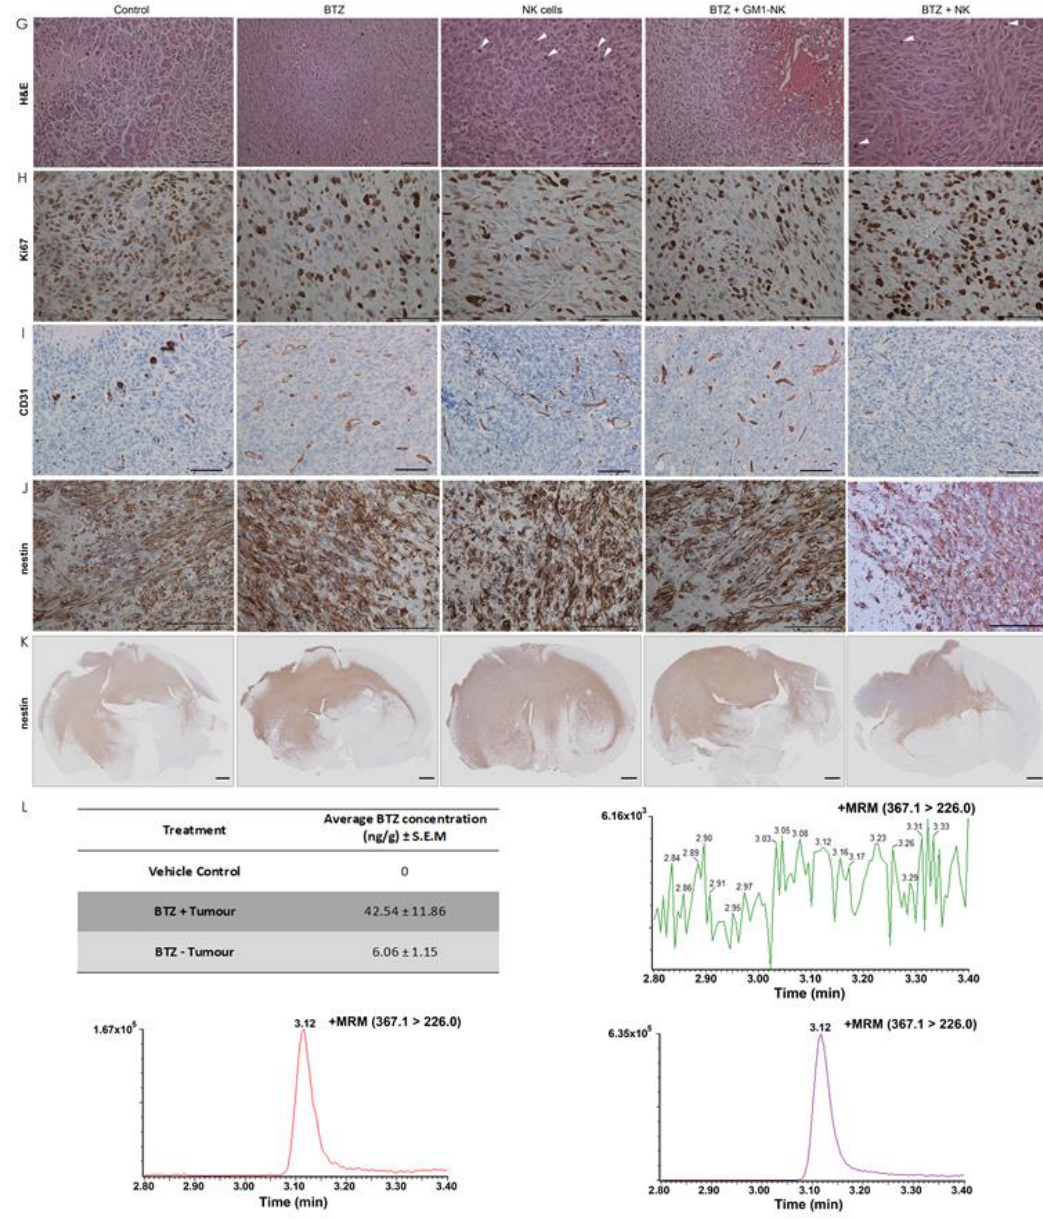
Figure 5. Treatment of GBM-bearing mice with bortezomib + NK cells. ( A ) Tumour implantation (~10 5 BG7 cells), treatment schedule (1.3 mg / m 2 BTZ at days 1, 4 and 8 and, 5 × 10 5 autologous NK cells 24 h after the first dose of BTZ) and frequency of MRI scans (7–10 days). ( B ) Axial T1-weighted with contrast longitudinal MRI follow-up of the same animal from each treatment group and follow-up post-implantation on days 40, 49, 56 and 66. ( C ) The mean ± SEM of tumour volumes (mm 3 ) and ( D ) Kaplan–Meier curves showing the % survival in days of all animals in the indicated treatment groups. The % mean ± SEM of ( E ) Ki67 labelling index and ( F ) CD31 microvascular density in all animals in the indicated treatment groups. Data represents n = 3 independent experiments. Two-way ANOVA, Bonferroni’s multiple comparison test, * P < 0.05; ** P < 0.01; *** P < 0.001; **** P < 0.0001. ( G ) Hematoxylin and Eosin (H&E) staining of sections from tumours treated with NK cells or BTZ + NK cells (magnification 200 × g ), ( H ) Ki67 staining (brown) hematoxylin counterstain, ( I ) CD31 staining (brown) for tumour microvessels, ( J ) human-specific nestin staining (brown) and ( K ) whole brain image of nestin staining (brown) of tumour tissue from one representative animal from each of the treatment groups indicated. ( G – J ) Magnification 400 × g , scale bar 100 µ M, arrows: NK cells, ( K ) magnification 10 × , scale bar 1 mm, animals sacrificed on days 67, 74, 98, 74 and 65, from left to right, respectively. ( L